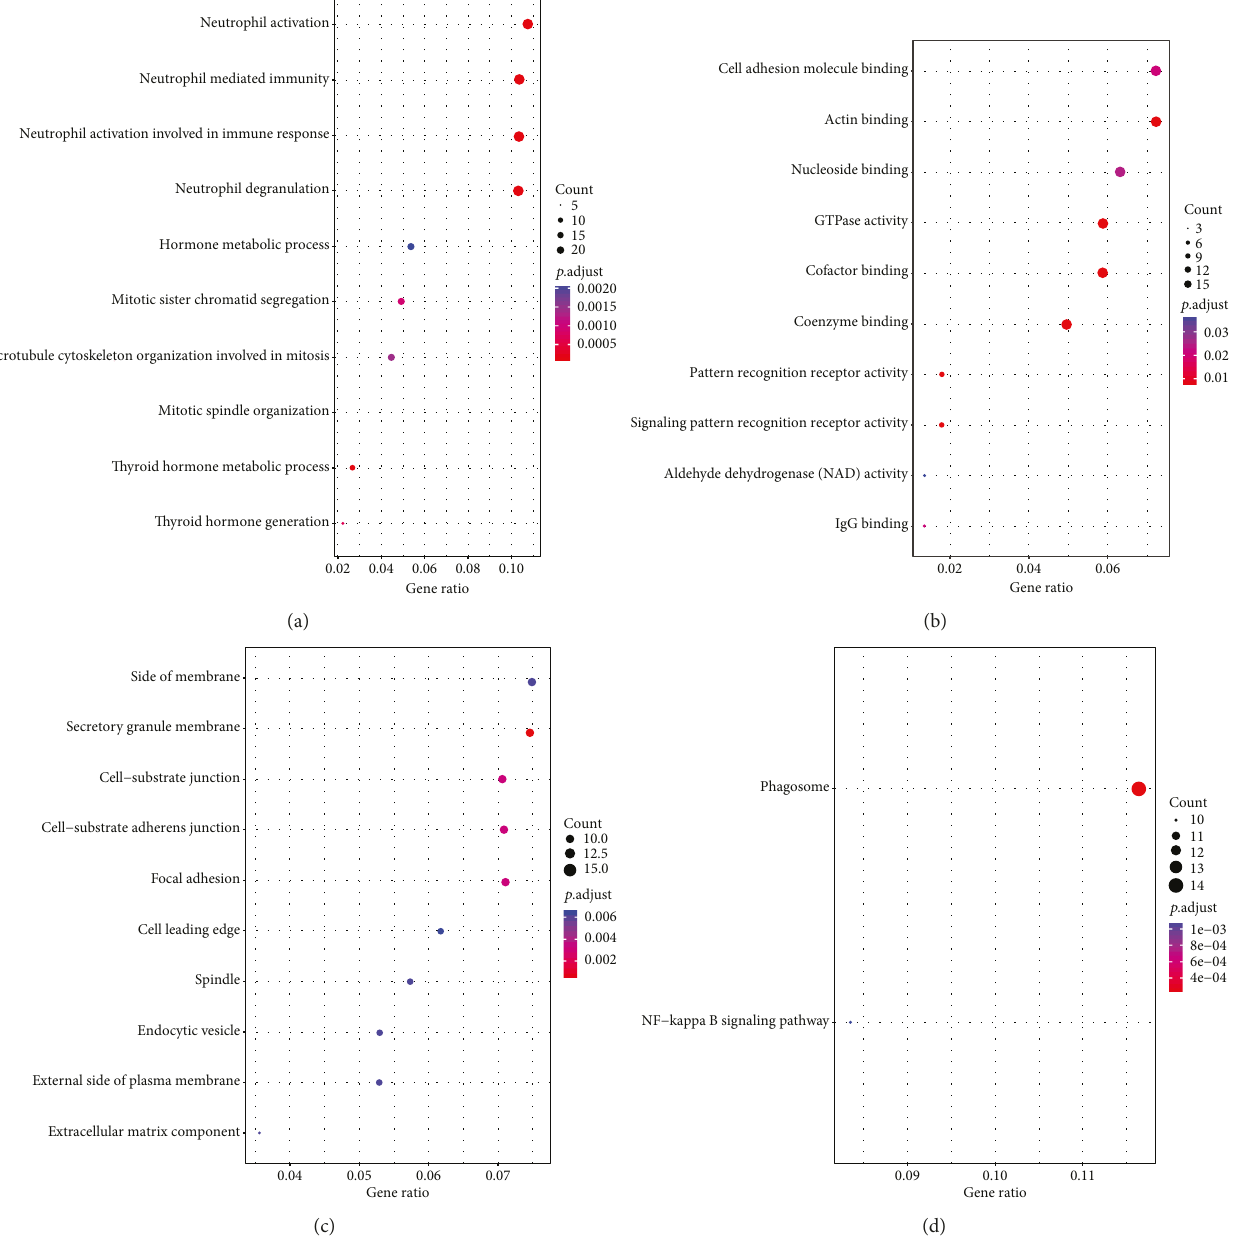
Figure 2: The top 10 gene ontology (GO) terms and signi fi cantly enriched KEGG pathways ((a) biological processes; (b) molecular functions; (c) cellular components; (d) KEGG